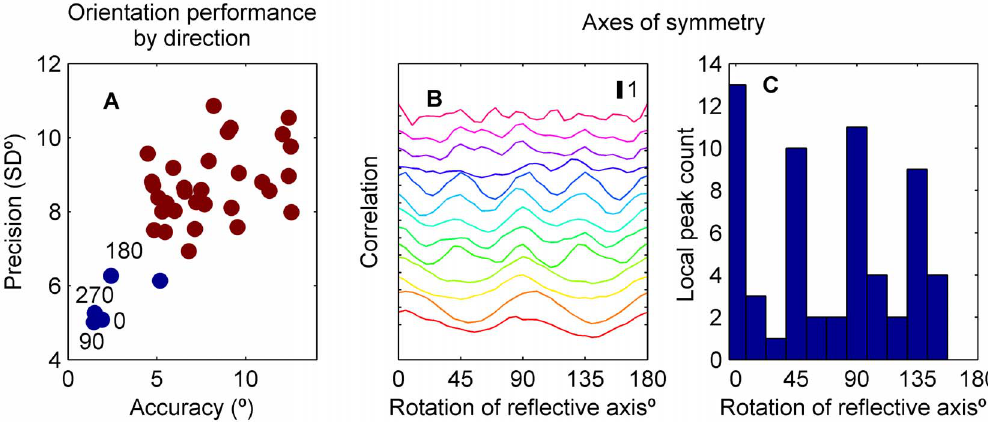
Figure 5. Analyses of cardinal-centric symmetry in orientation performance. (A) Comparison of population-mean precision and accuracy metrics illustrates that cardinal directions are associated with both higher accuracy and precision. Cluster analysis to the level of two groups resulted in one cluster containing the four cardinal directions and 300 u . (B) The circular cross-correlation of each participants’ direction-dependent orientation bias with its reflection – a measure of symmetry in the anisotropic judgement of directions. Each colour corresponds to a different participant, and curves have been vertically offset for clarity. Some participants exhibited correlations with 90 u periodicity whereas others with 45 u periodicity. In both cases, the highest correlations tended to occur across the cardinal axes. The histogram counts all local maxima in the cross-correlations of each participant; the most common axes of symmetry was indeed in the cardinal planes (0 u and 90 u rotation).